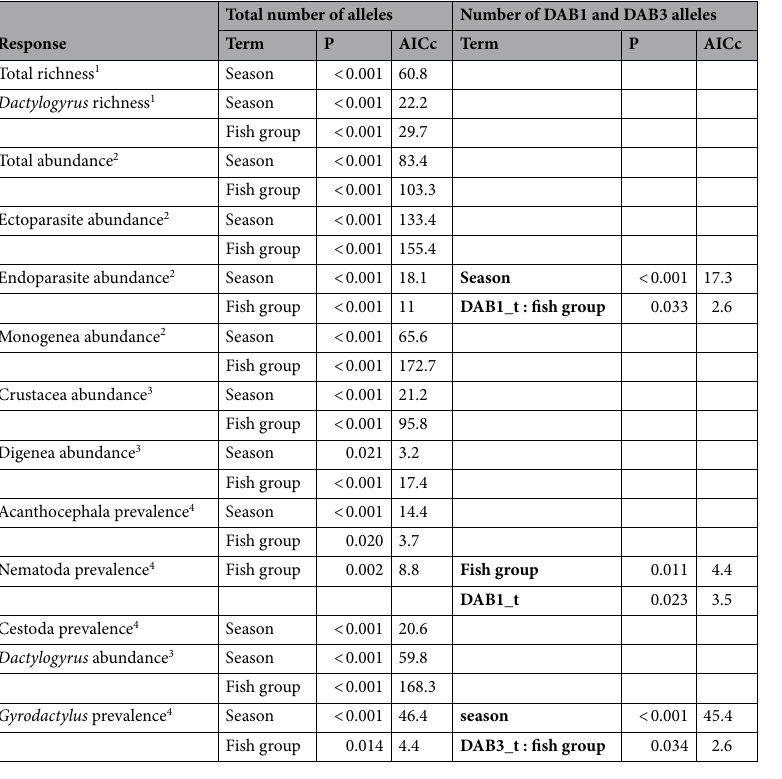
Table 4. Terms remaining in final models originating by backward stepwise regression from GLMMs detecting effects of season, fish group and number of alleles for 13 response variables (richness, abundance or, in case of prevalence ≤ 30%, prevalence was used instead of abundance). For each term, AICc and P of log-likelihood test for the term removal are shown. For models detecting effect of number of DAB1 and DAB3 alleles, only final models different from those using total number of alleles as predictor are shown (i.e. the significant effects of season and fish group are not shown in table for the models including number of DAB1 and DAB3 alleles). See methods for full model formulae. Terms of models where number of alleles played a role are in bold. Response distribution as specified in the model: 1 Poisson, 2 negative binomial, 3 Poisson with observation level random effects, 4